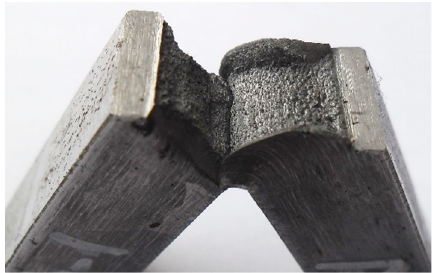
Figure 10. Fracture surface of the test sample with a notch in the HAZ on the face side of the weld. Values of the cooling time t 8/5 were obtained within range 28.5 to 32 s. Different theoretical formulas predict that values could range from 24 s (Ito-Bessyo formula) to 65 s (formula of limited thickness) [25], so the experimentally obtained values are in compliance with theoretically predicted